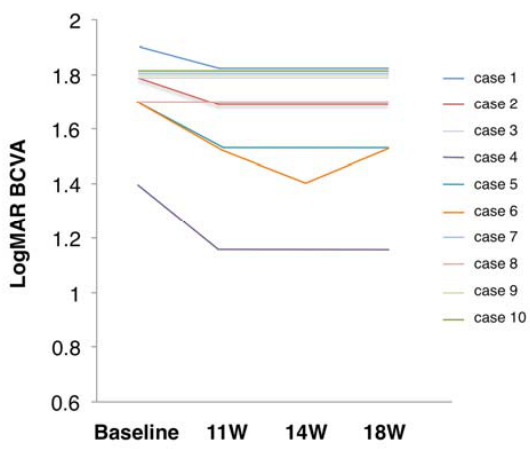
Figure 2. Changes in visual acuity from before to after skin electrical stimulation. LogMAR BCVA, logarithm of minimal angle resolution ‐ converted best ‐ corrected decimal visual acuity. Courses of individual cases.